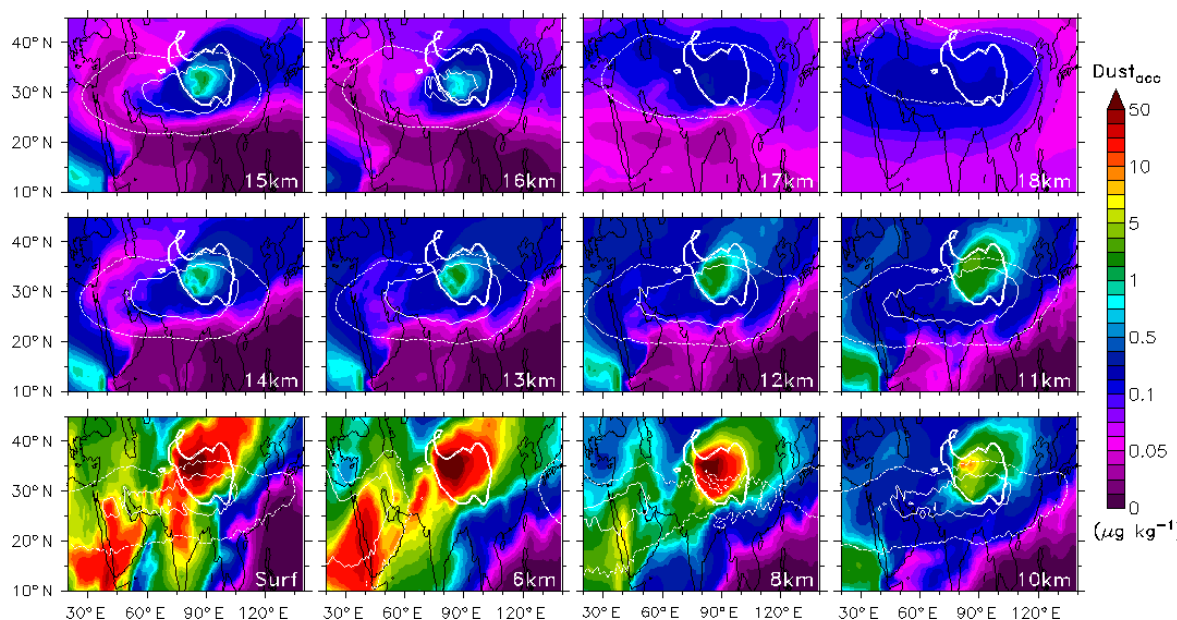
Figure 12. EMAC-simulated dust mass concentrations in the accumulation mode, Dust acc , in units of microgram of dust per kilogram of air (µgkg − 1 ) (note that a molecular weight of 40.08 is used for dust), at selected altitudes, i.e., at the surface and 6, 8, 10, 11, 12, 13, 14, 15, 16, 17, and 18kma.s.l., averaged for July–August 2012. Thin white lines refer to the contour of pressure deviation, as defined in Fig. 2, and thick white lines highlight the Tibetan Plateau area.